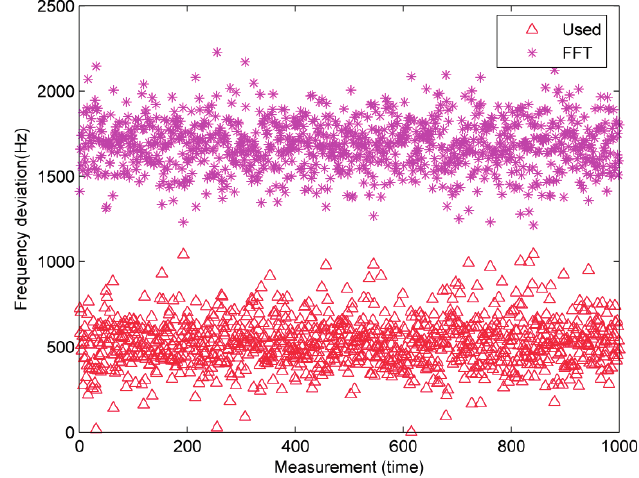
Figure 6. Absolute values of the deviations from the actual